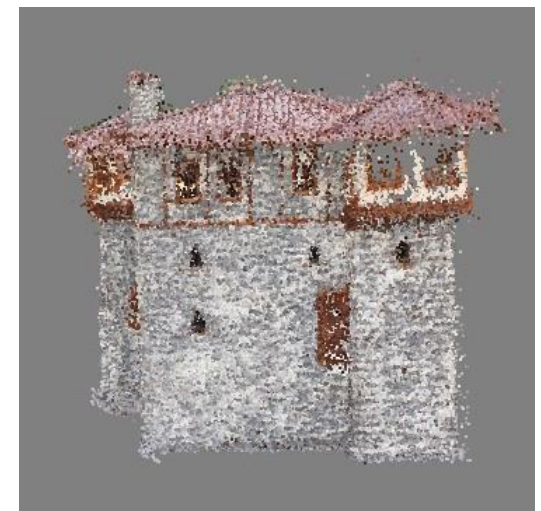
Figure 7: Dense point cloud produced in Agisoft Photoscan